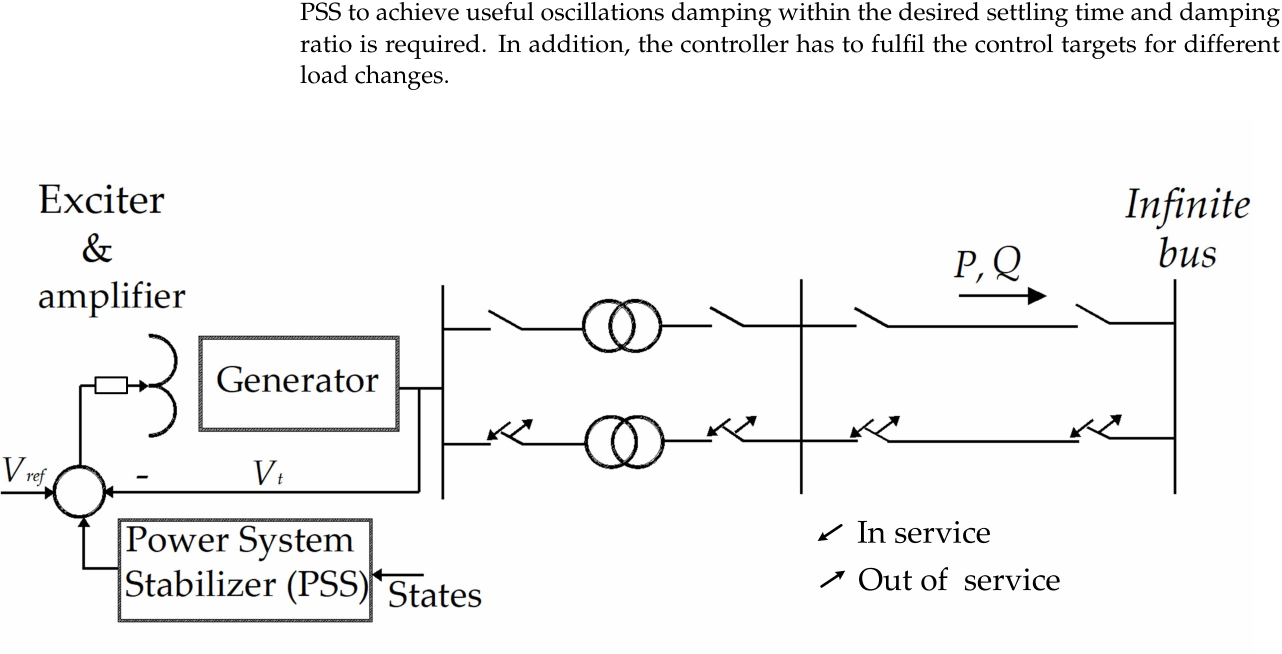
Figure 1. Block diagram of the studied system, single machine infinite bus (SMIB) under failure/repair